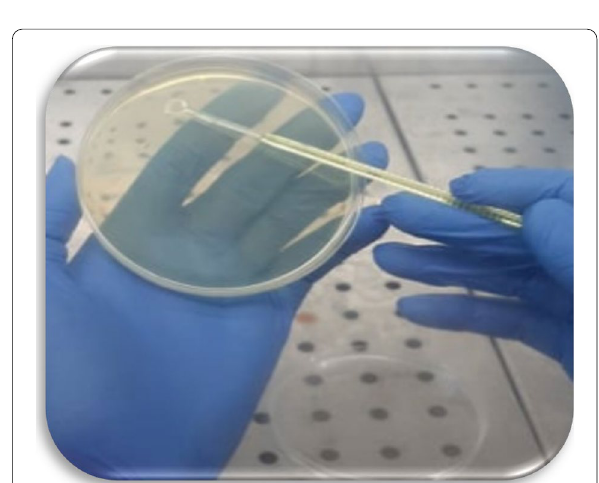
Fig. 4 Culturing on Bile esculin using sterile